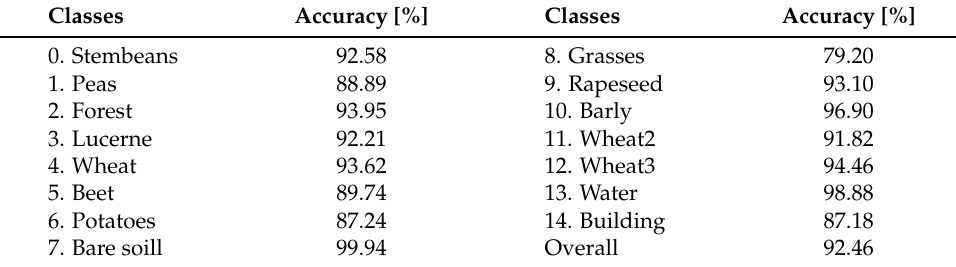
Table 3. Accuracy for the labeled area in the image of